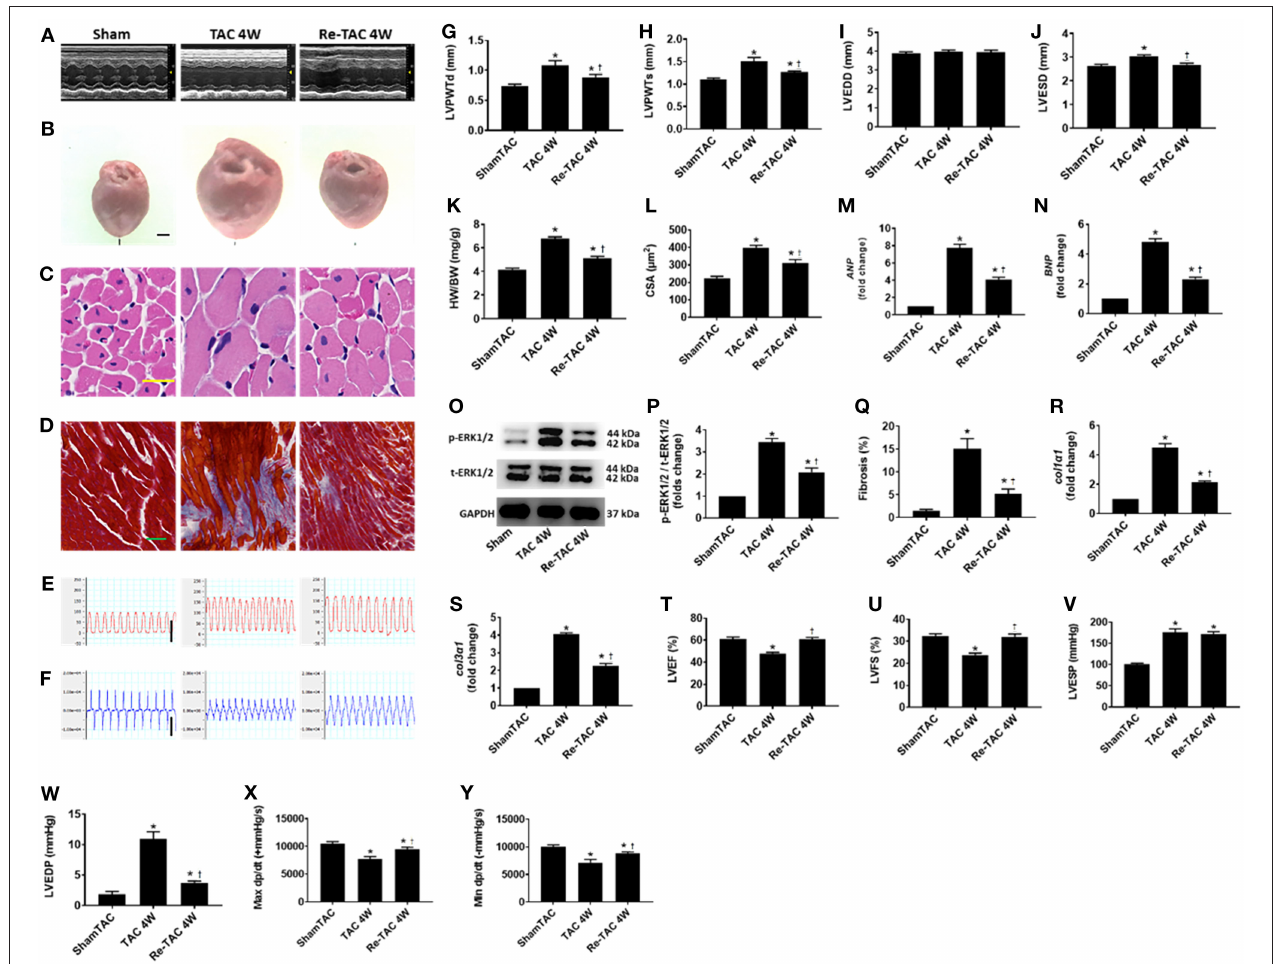
FIGURE 1 | Hypertrophic preconditioning improves cardiac morphological changes and function in pressure overload hearts. (A) M-mode echocardiography from Sham, TAC 4W, and Re-TAC 4W mice. (B) Gross appearance of hearts. Scale bar = 1mm. (C) Cardiomyocytes stained by H&E. Scale bar = 20 µ m. (D) Cardiac fibrosis stained by Masson’s trichrome. Scale bar = 50 µ m. Representative images of (E) LV pressure and (F) contraction and relaxation velocity (dp/dt). Scale bar = 100 mmHg for pressure, scale bar = 10,000 mmHg/s for dp/dt. (G,H) LV end-diastolic (LVPWTd) and end-systolic (LVPWTs) posterior wall thickness, respectively. (I,J) LV end-diastolic (LVEDD) and end-systolic (LVESD) dimension, respectively. (K) Heart weight-to-body weight ratio (HW/BW). (L) Cross-sectional area (CSA) of cardiomyocytes. (M,N) Real-time quantitative PCR analyses for the gene expression of atrial natriuretic peptide ( ANP ) and brain natriuretic peptide ( BNP ), respectively. Representative images (O) and densitometric assessment (P) of Western blot for ERK1/2 activation. (Q) Quantification of collagen staining expressed as % area. Gene expression of makers of cardiac fibrosis (R) collagen type I alpha 1 ( col1 α 1 ) and (S) collagen type 3 alpha 1 ( col3 α 1 ). Echocardiographic measurements of (T) LV ejection fraction (LVEF) and (U) LV fractional shortening (LVFS). Invasive hemodynamic assessment of (V,W) LV end-systolic (LVESP) and end-diastolic (LVEDP) pressure, respectively. (X,Y) Maximum (Max dp/dt) and minimum (Min dp/dt) value of LV dp/dt, respectively. * P < 0.05 vs. Sham TAC; † P < 0.05 vs. TAC